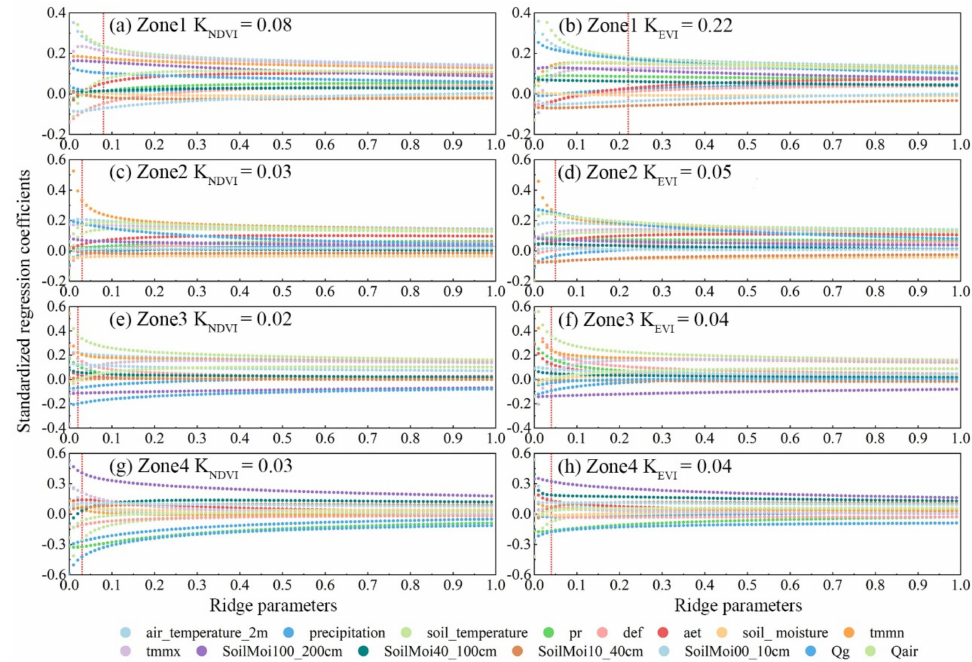
Figure 9. Ridge trace map obtained by Ridge Regression for NDVI and EVI. The red dotted line is the optimal K value, for the four study areas, where ( a – h ) are the ridge trace plots under the optimal K values of Zone 1–4, respectively. Table 9. Ridge Regression correlation coefficient summary, where the marked stars are the variables that passed the significance test (* p < 0.05 ** p <